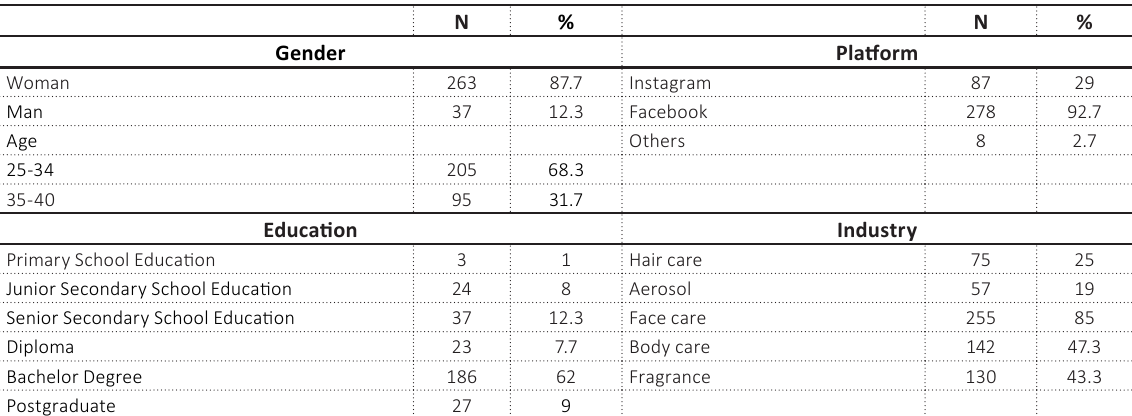
Table 1. Respondents’ profile